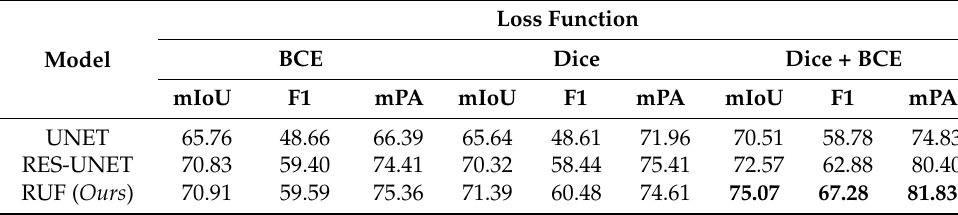
Table 4. Comparison of different loss functions for various model architectures using end-to-end training approach on validation set. BCE—Binary cross entropy loss; Dice—Dice loss; BCE + Dice— Equally weighted BCE and Dice Loss. Best results are in